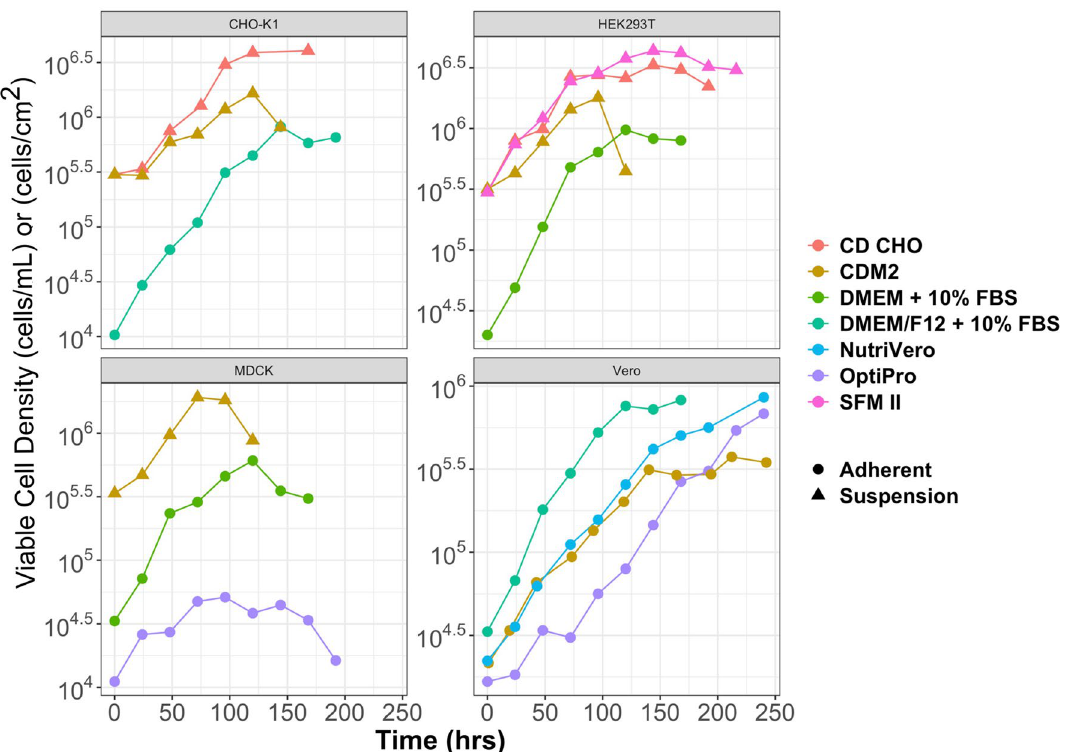
Figure 3. The chemically defined media that was formulated from the series of Plackett–Burman experiments was modified to include 1 mM Ca 2+ and 2 mM Mg 2+ (called CDM2) to support a higher growth rate in Vero cells. CHO-K1, HEK293T and MDCK cells were slowly adapted to CDM2 from serum-containing basal media. All three cell types were able to grow in suspension (triangle) when they were fully adapted to CDM2 and were cultured in shaker flasks. Vero cells remained adherent for all media formulations. Suspension (filled triangle), adherent (open Changes in regulation of proliferation and apoptosis. GSEA analysis was used to identify the most consistent expression changes in gene sets. An enrichment map of the significant down-regulated GO-terms in biological processes with a stringent FDR threshold of 5% can be seen in Fig. 4 (Supplementary Table S8). Overall, 151 gene sets were significantly down-regulated, and 91 were identified as significantly up-regulated. Most down-regulated gene sets were related to cell cycle regulation, mitosis, DNA-replication and DNA organi- zation which is consistent with the observation of the long doubling time of Vero in suspension (Fig. 5a) 33–35 . Suspensions cells had down-regulated genes from each part of cell cycle progression compared to adherently grown Vero cells in CDM2 (Fig. 5b). The gene c-myc is down-regulated in suspension Vero cells, and this gene has been associated with cell cycle progression, along with tumorogenesis 36 . The overexpression of this gene has been shown to allow quiescent cells to reenter the cell cycle and begin to proliferate 36 . Up-regulated genes were linked to inflammation, fluid shear stress, migration and endothelial barriers, indicating a stress response during cell adaption to suspension. Importantly, gene sets related to regulation of programmed cell death were not detected as either down- or up-regulated. Genes sets regulating apoptosis were not detected as differentially expressed by GSEA, as seen by the expression patterns of positive regulatory (GO:0043065) and negative regu- latory (GO:0043066) gene sets related to apoptotic processes (Fig. 5c). Despite a wider log fold-change (LFC) range for pro-apoptotic genes and anti-apoptotic genes, the average LFC for both sets of genes is approximately zero for Adh samples, and only slightly positive for Sus samples. The highest LFC for anti-apoptotic genes lrp2 , pkhd1 and tmigd1 have been shown to specifically protect renal cells from apoptosis 37–39 . On the other hand, for the top up-regulated pro-apoptotic genes, tnfsf10 has been proven to trigger apoptosis in renal cells. The expression of apoptogenic genes like bax , bak1 , or bad were unaffected, whereas, anti-apoptic genes are either unchanged like mcl1 or bcl2l2 or increase like bcl2 40 . Overall, the pattern does not seem conclusive for the Sus samples to indicate a change in the rate of apoptosis due to the widespread expression changes of both pro- and anti-apoptosis regulating gene sets. Mitochondrial fatty acid metabolism. The fatty acid (FA) beta oxidation pathway is the main up-regu- lated gene set in the GSEA amino acid and lipid metabolism cluster (Fig. 4). The product of this pathway, acetyl- CoA, is further converted in the Krebs cycle for energy production. The expression changes of FA beta oxidation in Sus samples are presented in Supplementary Fig. S6. The heatmap in Fig. S6b illustrates the upregulation of 29 beta oxidation associated genes. The schematic diagram in Fig. S6a illustrates that for each step in fatty acid